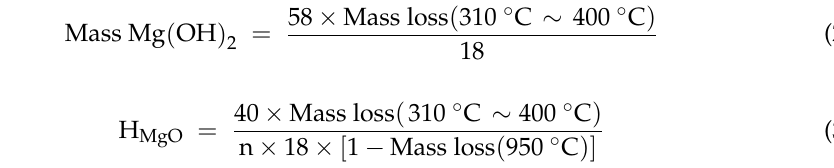
Figure 8. Effect of temperature on autogenous deformation of MEA concrete at early stage. ( a ) autogenous deformation, containing 0% MEA. ( b ) autogenous deformation, containing 6% MEA. ( c ) autogenous deformation, containing 8% MEA. ( d ) autogenous deformation, containing 10% MEA.